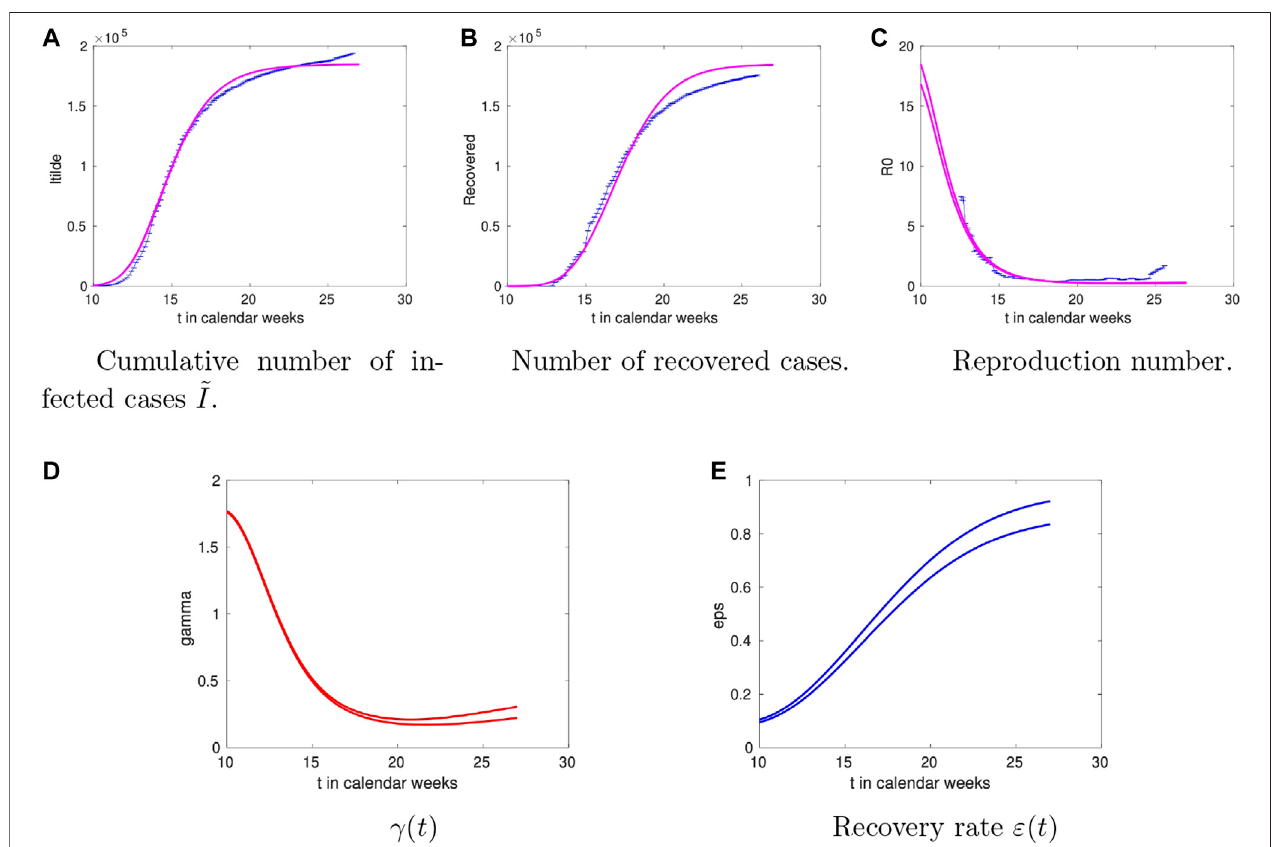
FIGURE 3 | Time dependence of ~ I ( t ) , R ( t ) , R 0 ( t ) , c ( t ) and ε ( t ) within the eRG SIR model optimised to describe the German data for COVID-19. Solid lines are the model (shown as a 95% con fi dence level band for the predictions) and the dots with error-bars are the